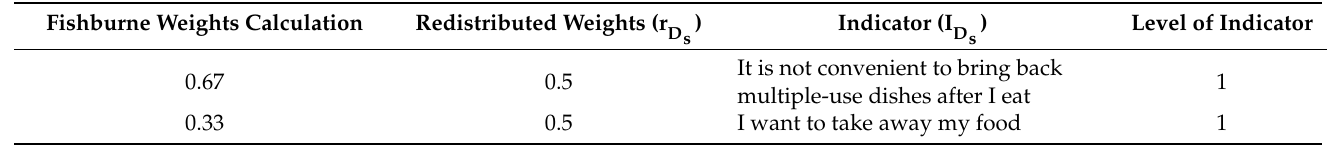
Table 19. Reasoning indicators for single ‐ use dishes.